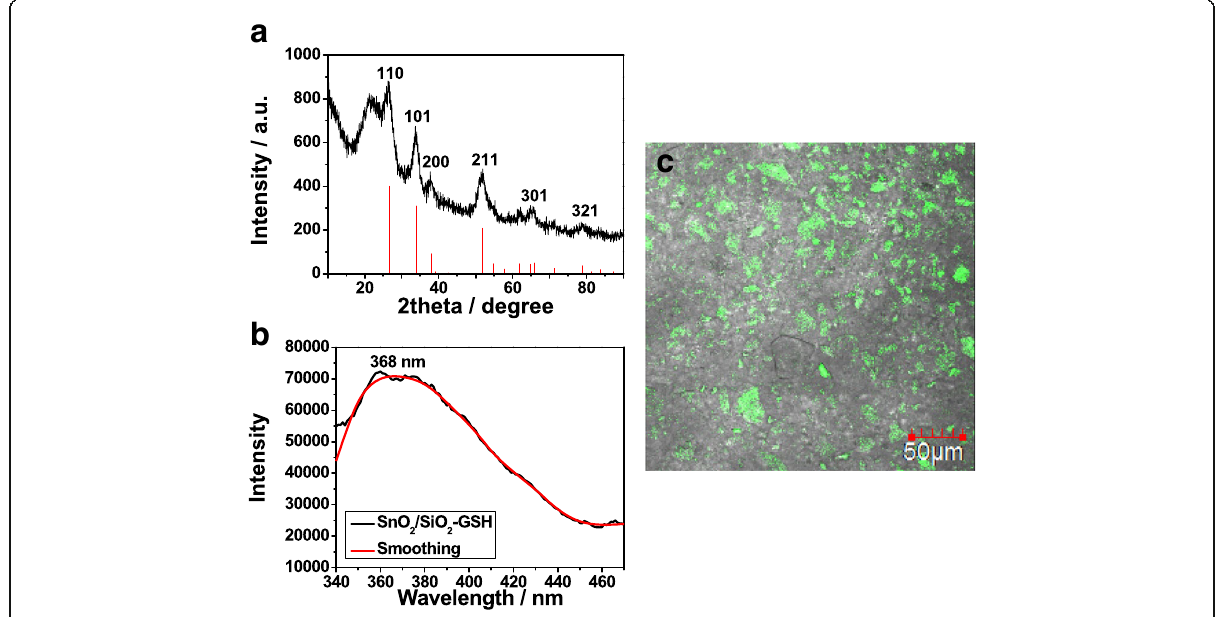
Fig. 3 XRD pattern ( a ), fluorescence spectrum (b ), and fluorescence imaging ( c ) of prepared SnO 2 /SiO 2 -GSH NSs